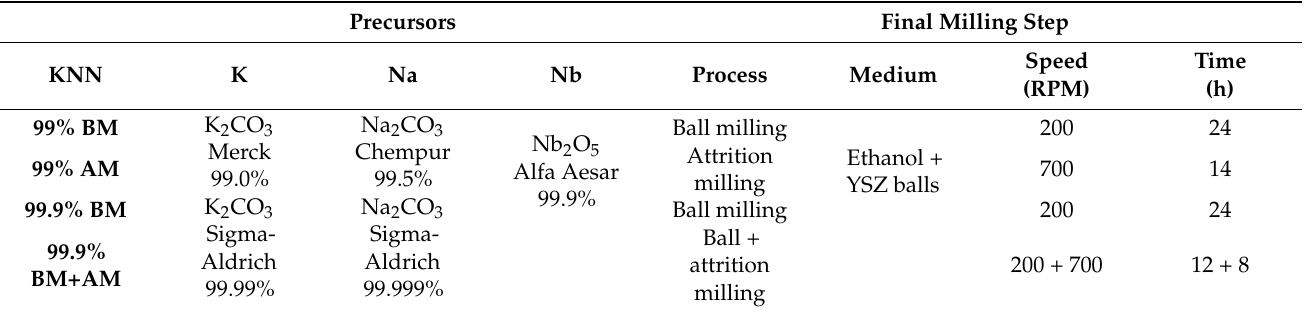
Table 1. Precursors and experimental details on powder